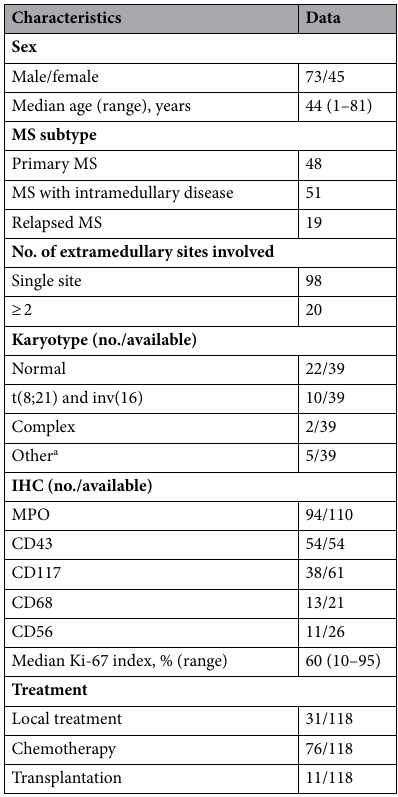
Table 1. Patients and characteristics in the diagnosis of MS. MS myeloid sarcoma, IHC immunohistochemistry; a t(9;22), t(6;11), t(9;11), der(7;8), 5q −